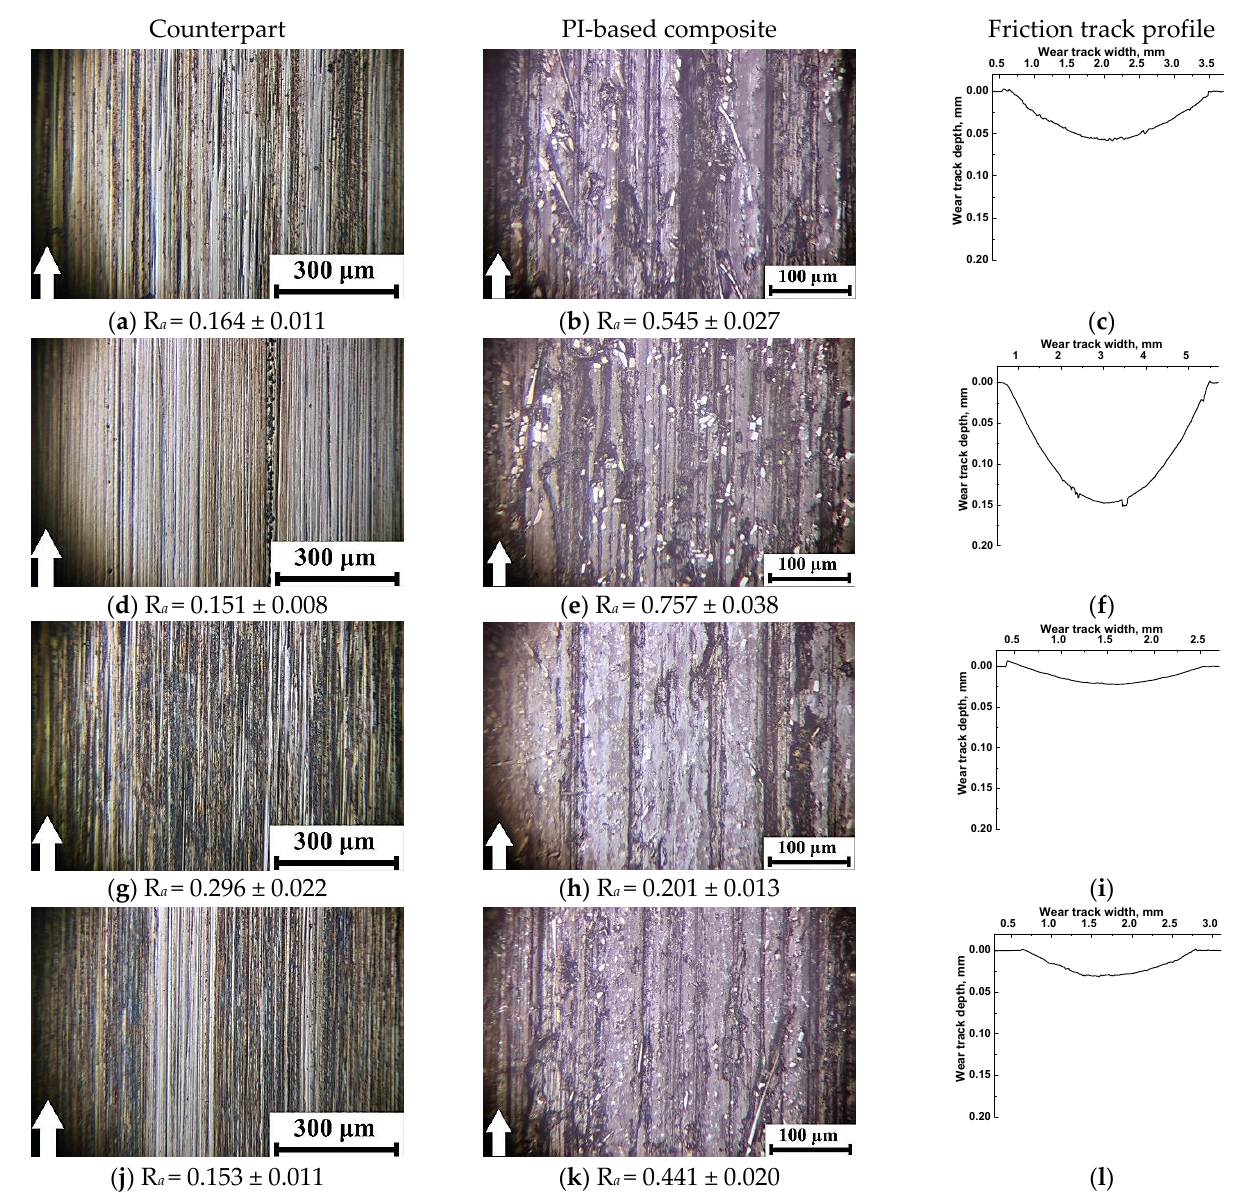
Figure 11. The micrographs of the wear tracks on the metal counterpart and the PI/10CCF ( a – c ), PI/10CCF/10PTFE ( d – f ), PI/10CCF/10Gr ( g – i ), and PI/10CCF/10MoS 2 ( j – l ) composites. The ‘severe’ mode ( P = 180 N; V = 0.3 m/s).